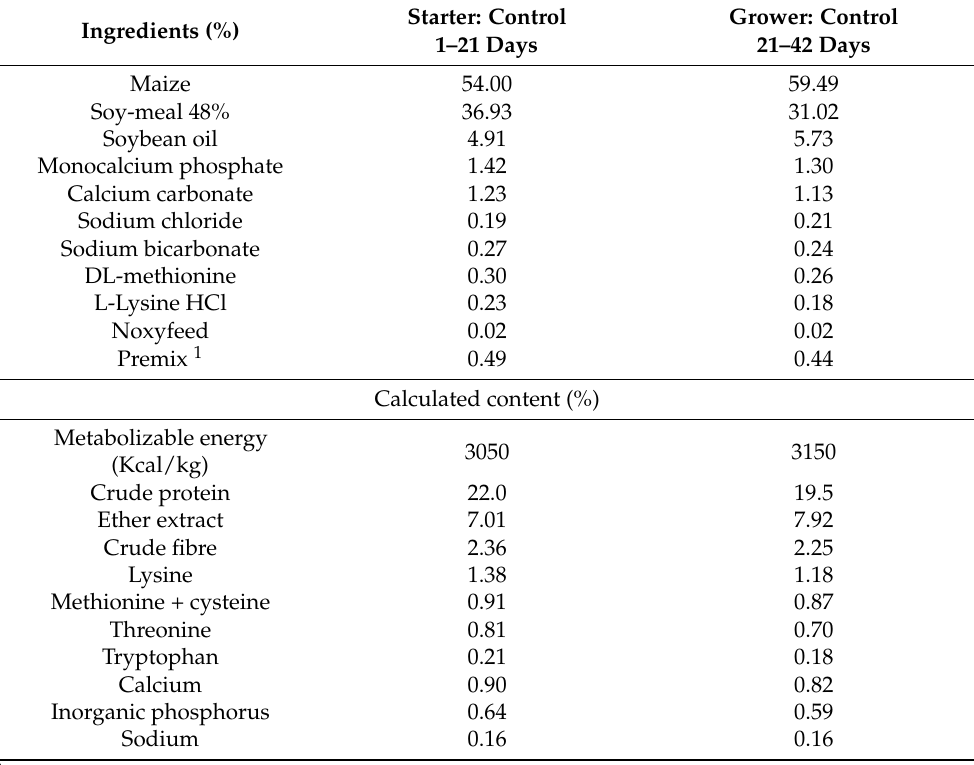
Table 1. Formulation and proximate analysis of control